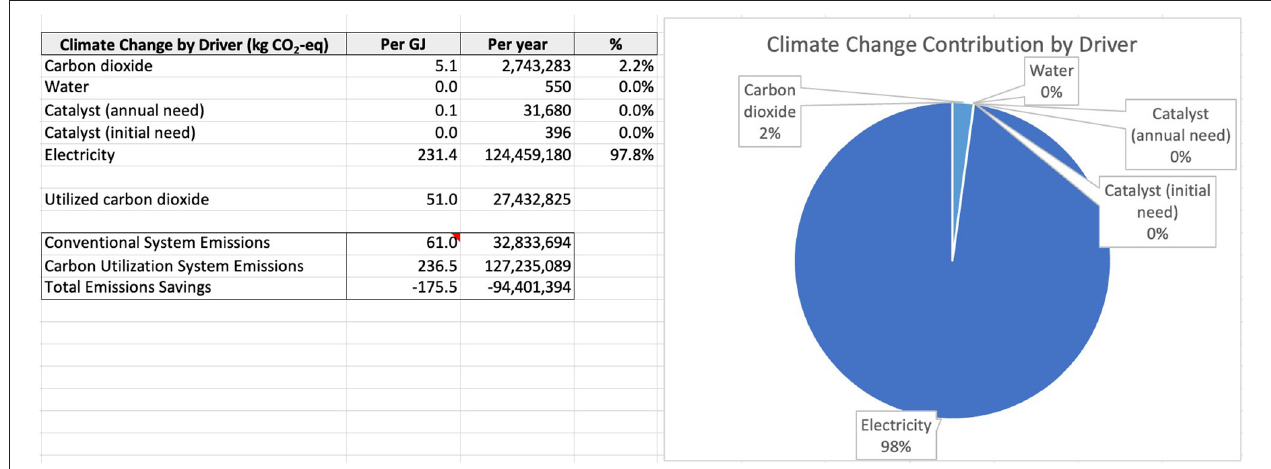
FIGURE 4 | Summary table and pie chart for LCA impact assessment showing distribution of emissions between raw material, catalyst, and electricity needs along with total system